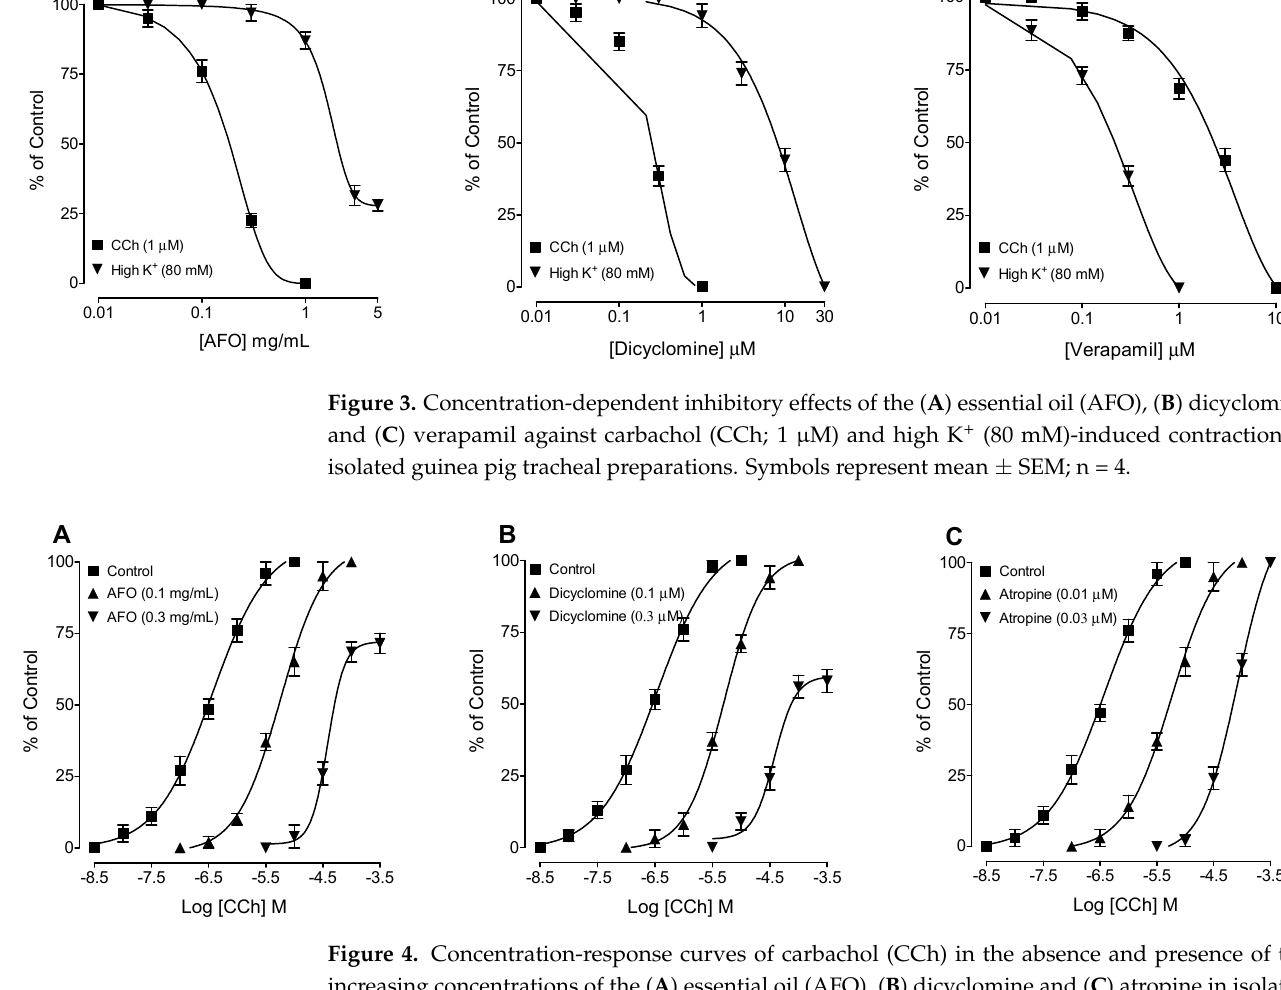
Figure 4. Concentration-response curves of carbachol (CCh) in the absence and presence of the increasing concentrations of the ( A ) essential oil (AFO), ( B ) dicyclomine and ( C ) atropine in isolated guinea pig tracheal preparations. Symbols represent mean ± SEM; n = 5.